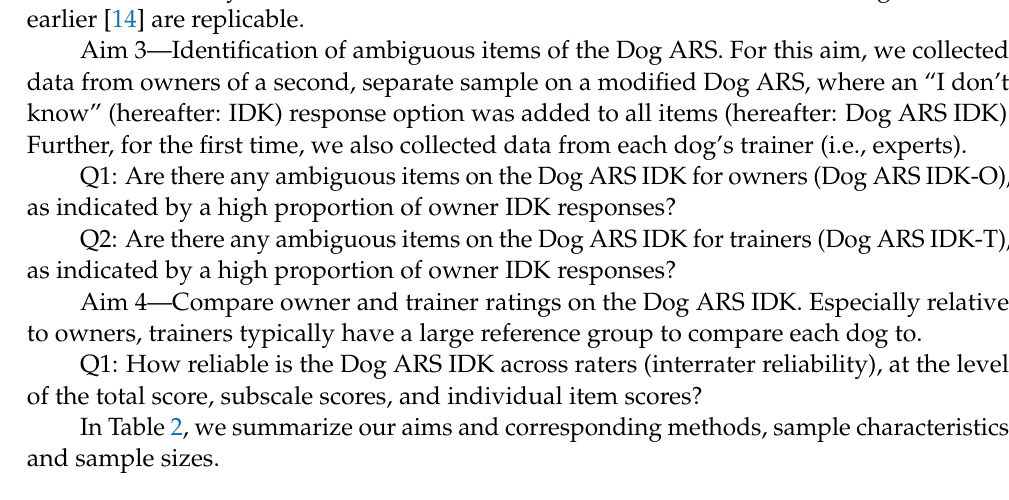
Table 2. Summary of the aims and corresponding methods and samples used in the present